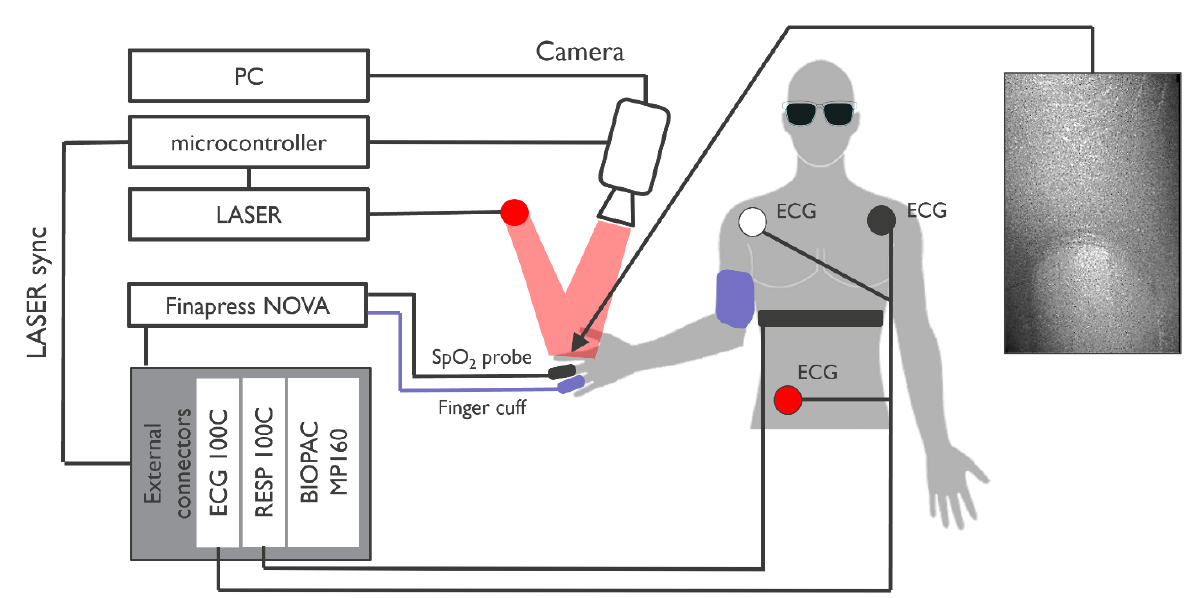
Figure 1. Block diagram of the experimental setup with example of image captured by the system (320 × 512 px). (320 × 512